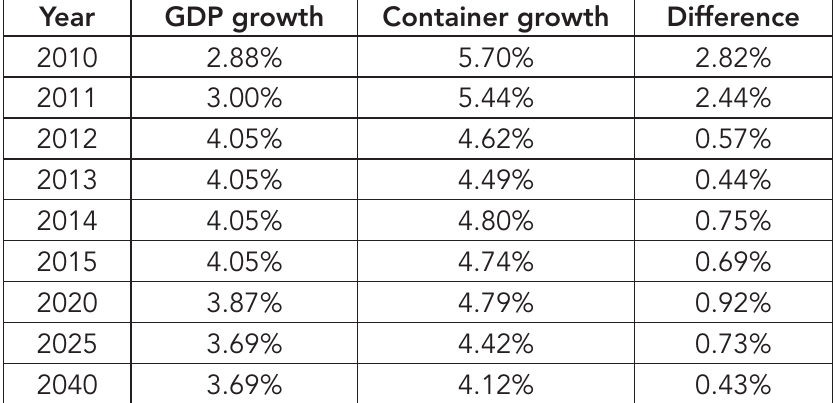
Table 4: GDP growth, container forecast and difference per forecast interval